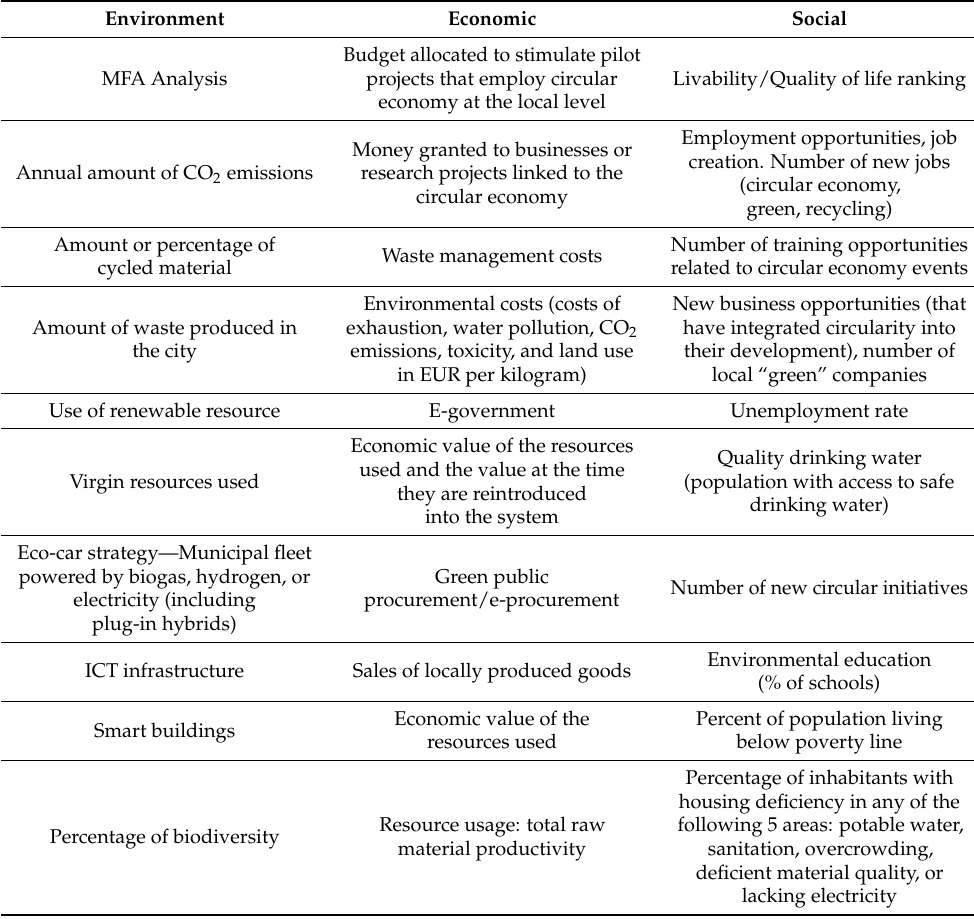
Table 1. Circular cities